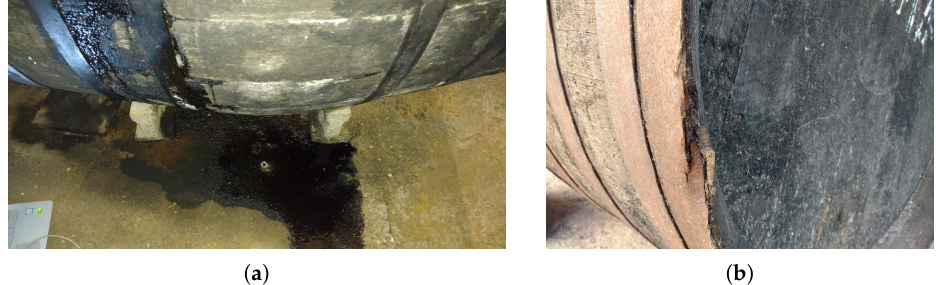
Figure 12. Defective casks. ( a ) Cask losing wine through small cracks. ( b ) Defective cask due to a received